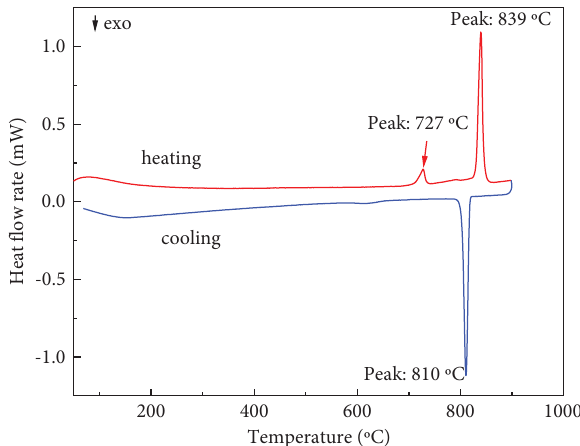
Figure 4: DSC diagram of pristine m-NaMnPO